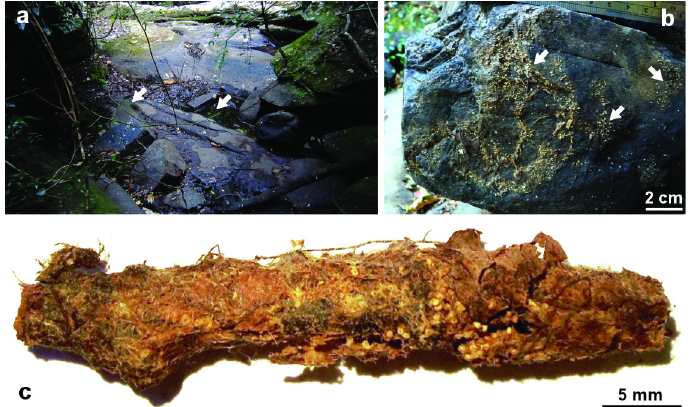
Fig. 3. Umborotula bogorensis (Weber, 1890) from the Sakaerat Biosphere Reserve, NE Thailand. a. sampling site along a temporary streamlet and pool; arrows indicate the microhabitat of the two recorded specimens. b . Gemmule carpets (arrows) during low water level (dry season). c . Encrusting sponge with gemmules on a stick from the